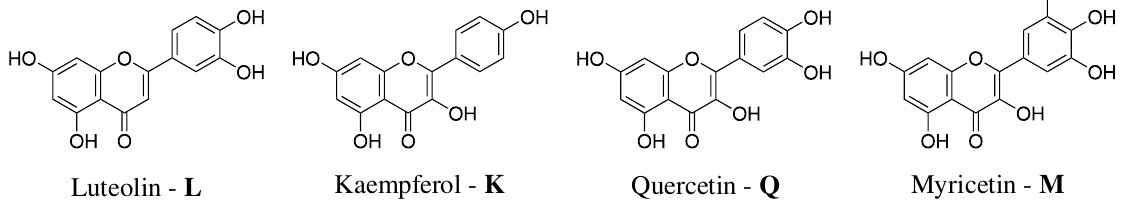
Figure 1. Molecular structure of the studied